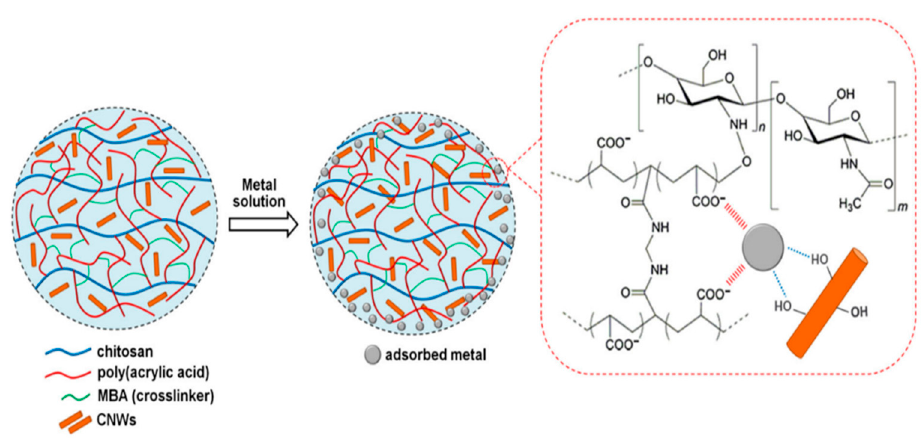
Figure 16. The coordination interaction between chitosan-g-poly (acrylic acid)/cellulose nanowhiskers hydrogel beads and adsorbed metal. (Reprinted by permission from Ref. [176]. Copyright (2022), Springer). Table 6. Proposed synthesis and removal mechanism of various hydrogel-based adsorbents.